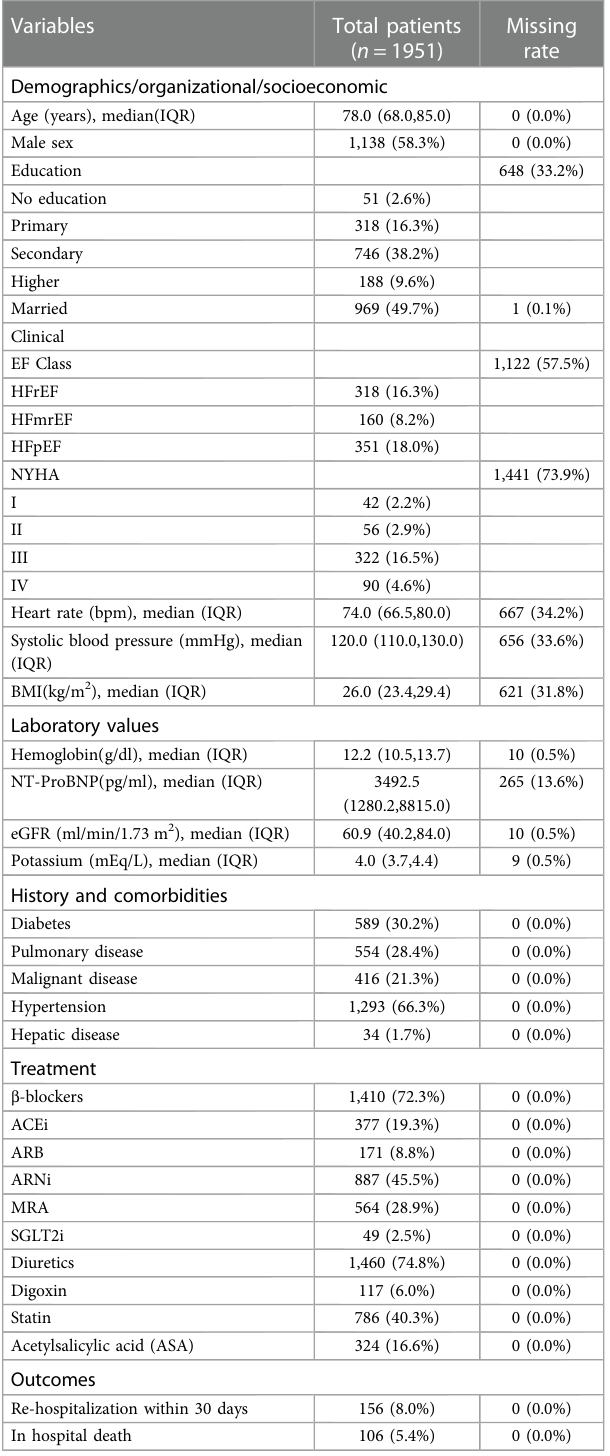
TABLE 1 Baseline characteristics at hospitalization discharge for retrospective cohort 2019 – 2021.